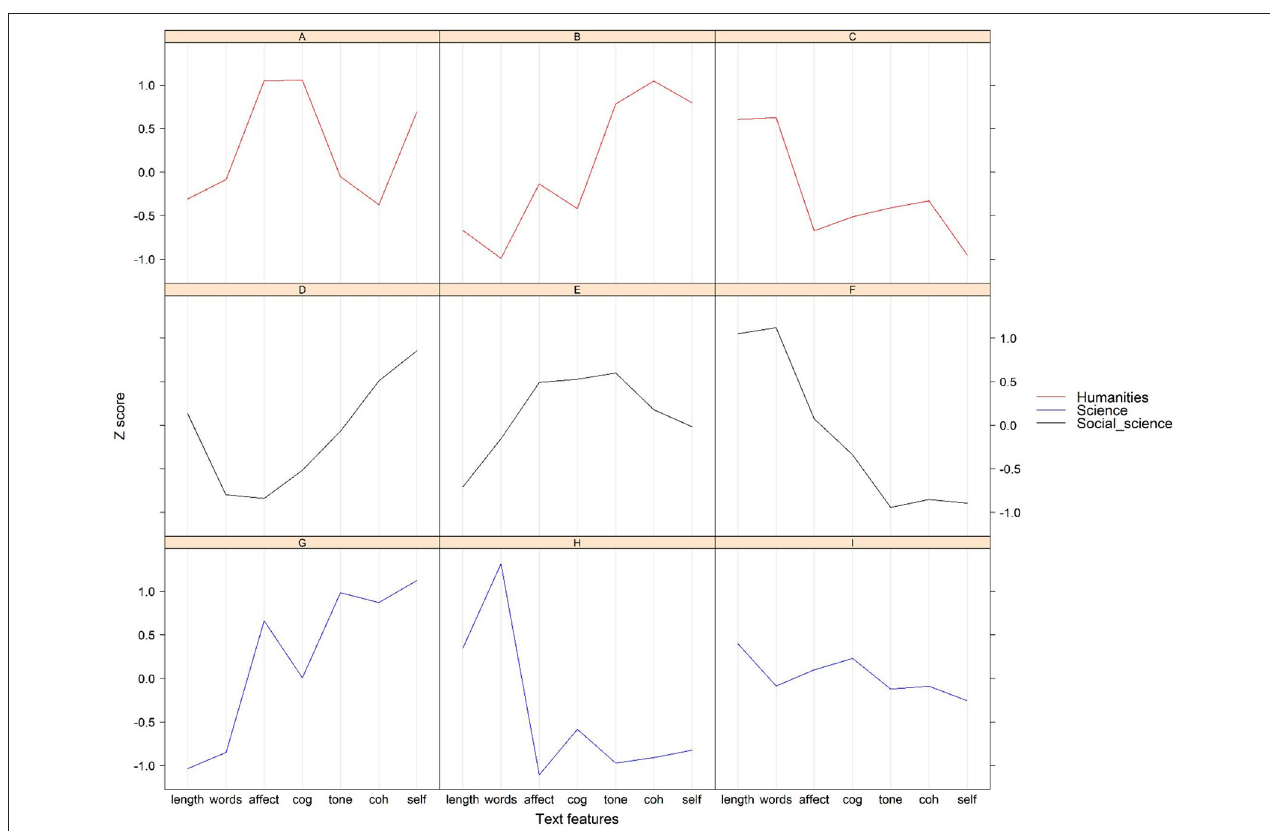
FIGURE 3 | Semantic features of lecture styles in different